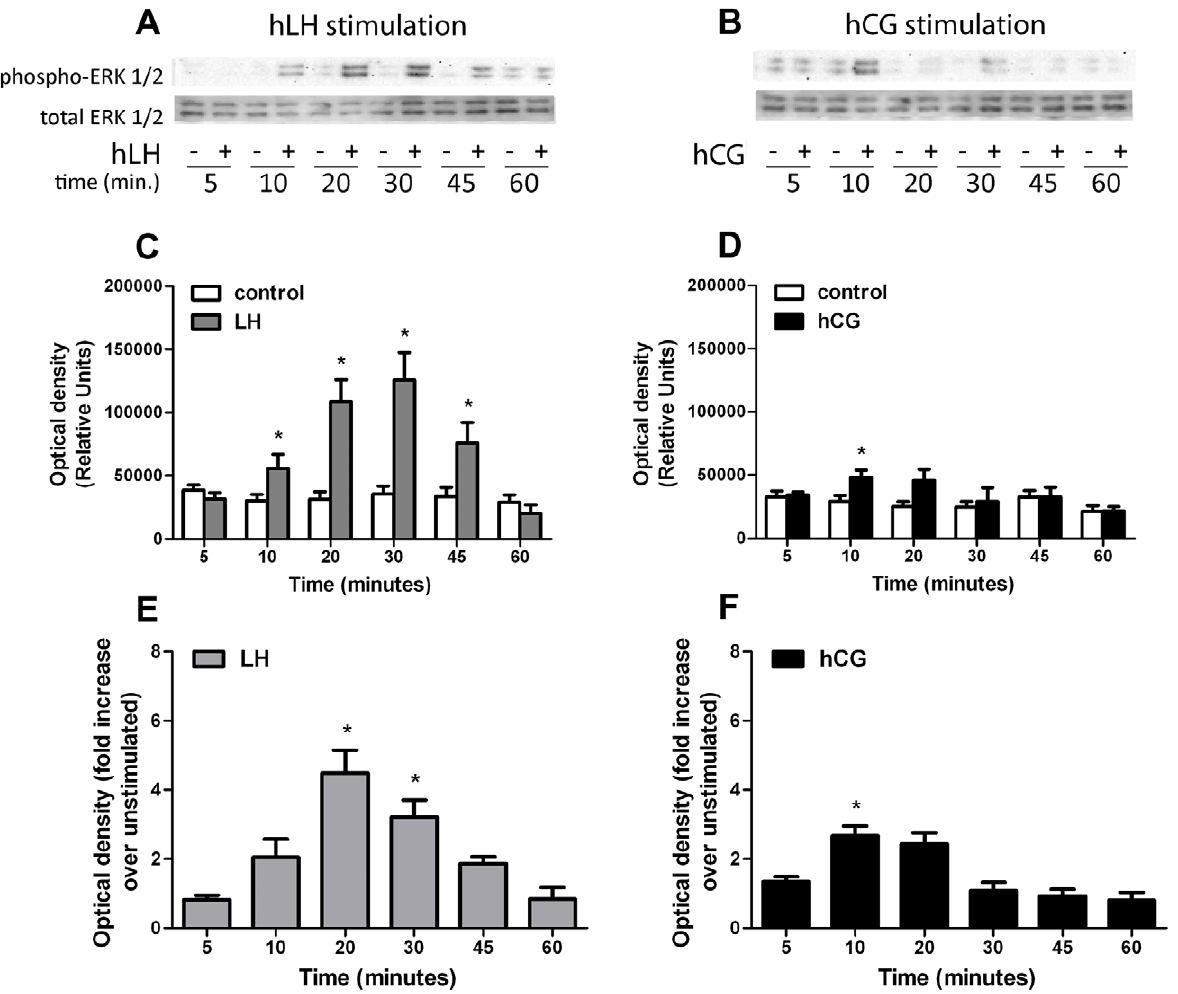
Figure 6. Time-course analysis of the phospho-ERK1/2 activation in hGLC under 100 pM hLH or 100 pM hCG stimulation. a. Comparison of phospho-ERK1/2 activation in hLH-stimulated vs unstimulated (control) at different time-points, by Western blotting (image is representative of 4 independent experiments; total ERK as normalizer). b. Comparison of phospho-ERK1/2 activation in hCG-stimulated vs unstimulated (control) at different time-points, by Western blotting (image is representative of 4 independent experiments; total ERK as normalizer). c, d. Relative semi-quantification of the optical density representing phospho-ERK1/2 activation (shown in figs. 6A,B) stimulated by ( c ) hLH or ( d ) hCG, compared to unstimulated (Mean 6 SEM; n=4; *=significant vs unstimulated; t-test ; p , 0.05). e. Normalization of the phospho-ERK1/2 signals measured in hLH-stimulated samples (represented as relative units in Fig. 6C) over each unstimulated (Mean 6 SEM; n=4; *=significant vs unstimulated; two-way analysis of variance ; p , 0.05). f. Normalization of the phospho-ERK1/2 signals measured in hCG-stimulated samples (represented as relative units in Fig. 6D) over each unstimulated (Mean 6 SEM; n=4; *=significant vs unstimulated; two-way analysis of variance ; p ,